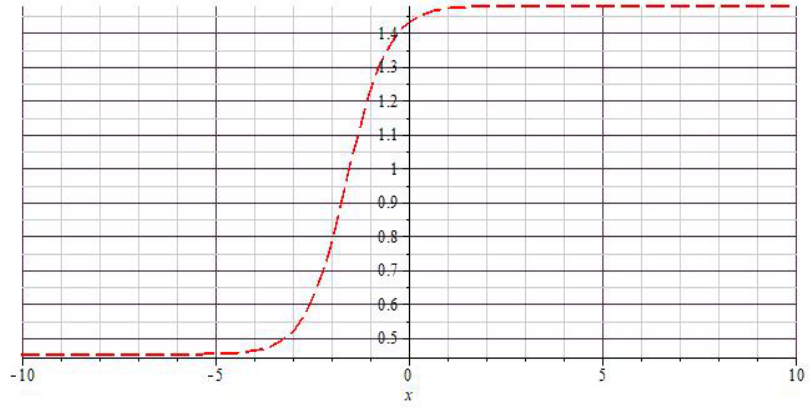
Figure 3. Graphical view of | Q 13 ( (cid:36) ) | for A 1 = 0.69, c 0 = 0.7, (cid:101) = 0.1, c 2 = − 1.26, A 0 = 0.45 and (cid:36) 0 = 1.6: ( a ) 3D plot, ( b ) contour plot, and ( c ) 2D plot at t = 0.